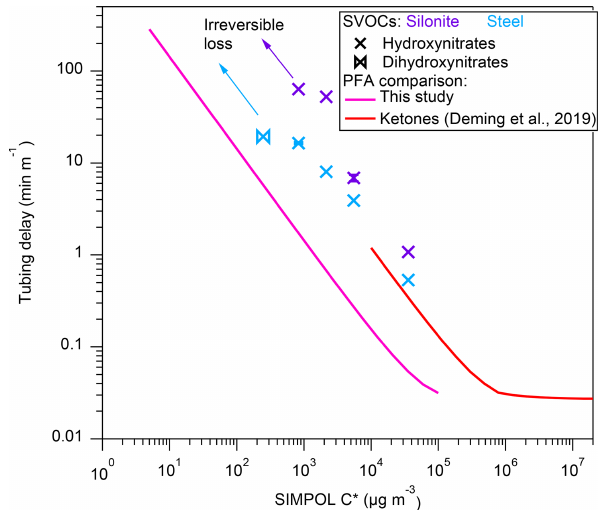
Figure 5. Stainless-steel and Silonite depassivation delay times measured for a series of HNs and DHNs after equilibration with a chamber filled with alkanols and S/IVOCs, and compared with PFA modeled delays for 4Lmin − 1 flows. Only compounds with 100% transmission efficiency through stainless steel and Silonite compared to Teflon tubing are shown. DHCs were not included in delay calculation due to relatively low S/N ratios in these ex- periments. The transmission became lower than 100% for DHCs with C ∗ < 10 2 µgm − 3 through steel and C ∗ < 10 3 µgm − 3 through Silonite. Example error bars (smaller than marker) were propagated from exponential